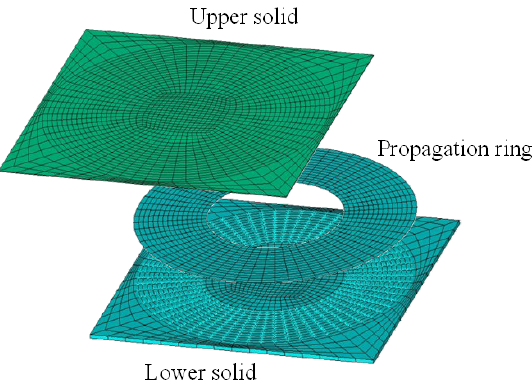
Figure 3. Delamination region model.